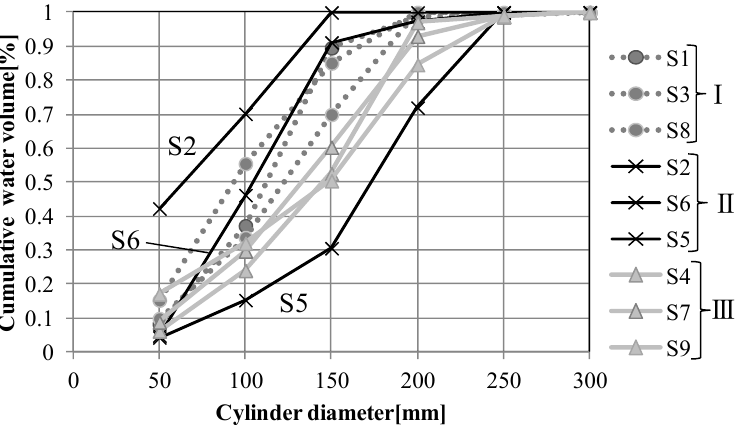
Figure 2. Results of spray